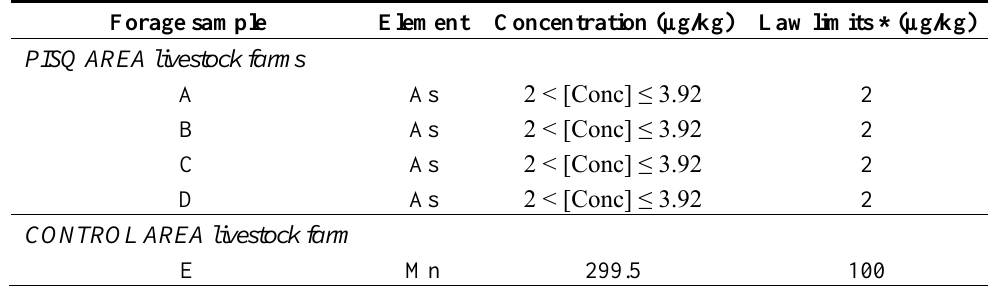
Table 4. Toxic elements concentration in forage